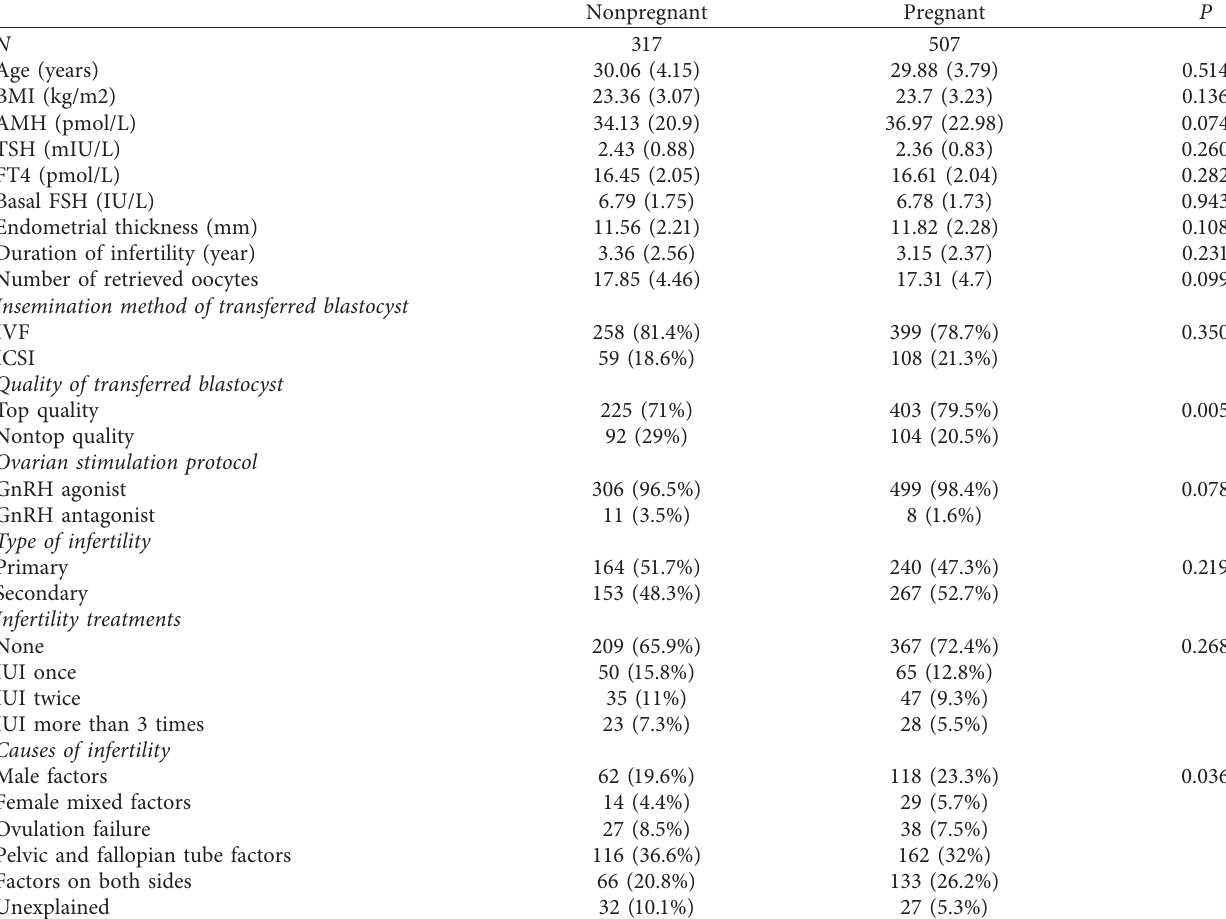
Table 2: General characteristics between pregnant and nonpregnant